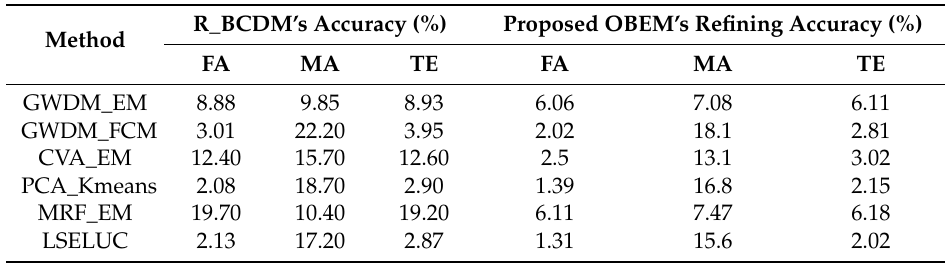
Table 5. Comparison between existing preprocessing methods and the OBEM post-processing approach for the second data set (aerial images with 0.5 m/pixel resolution).